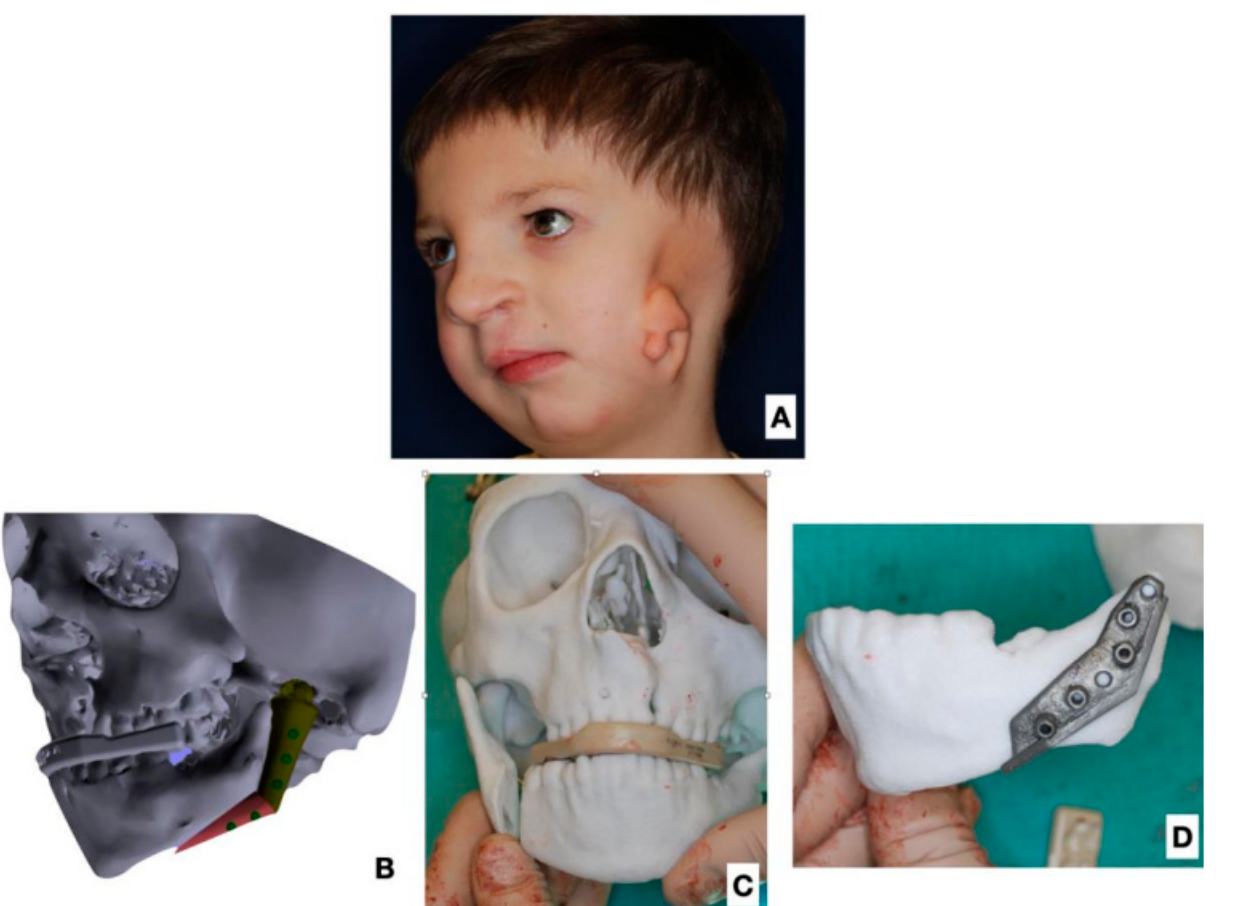
Figure 1. Patient 5 years old with HF Pruzansky III. ( A ) Three-quarter view, soft tissue deformity vis- ible, with auricle microtia. ( B ) 3D image reconstruction with planned free fibular flap reconstruction. ( C ) Stereolithographic model for intraoperative planning and control. ( D ) Stereolithographic model with intraoperative template.